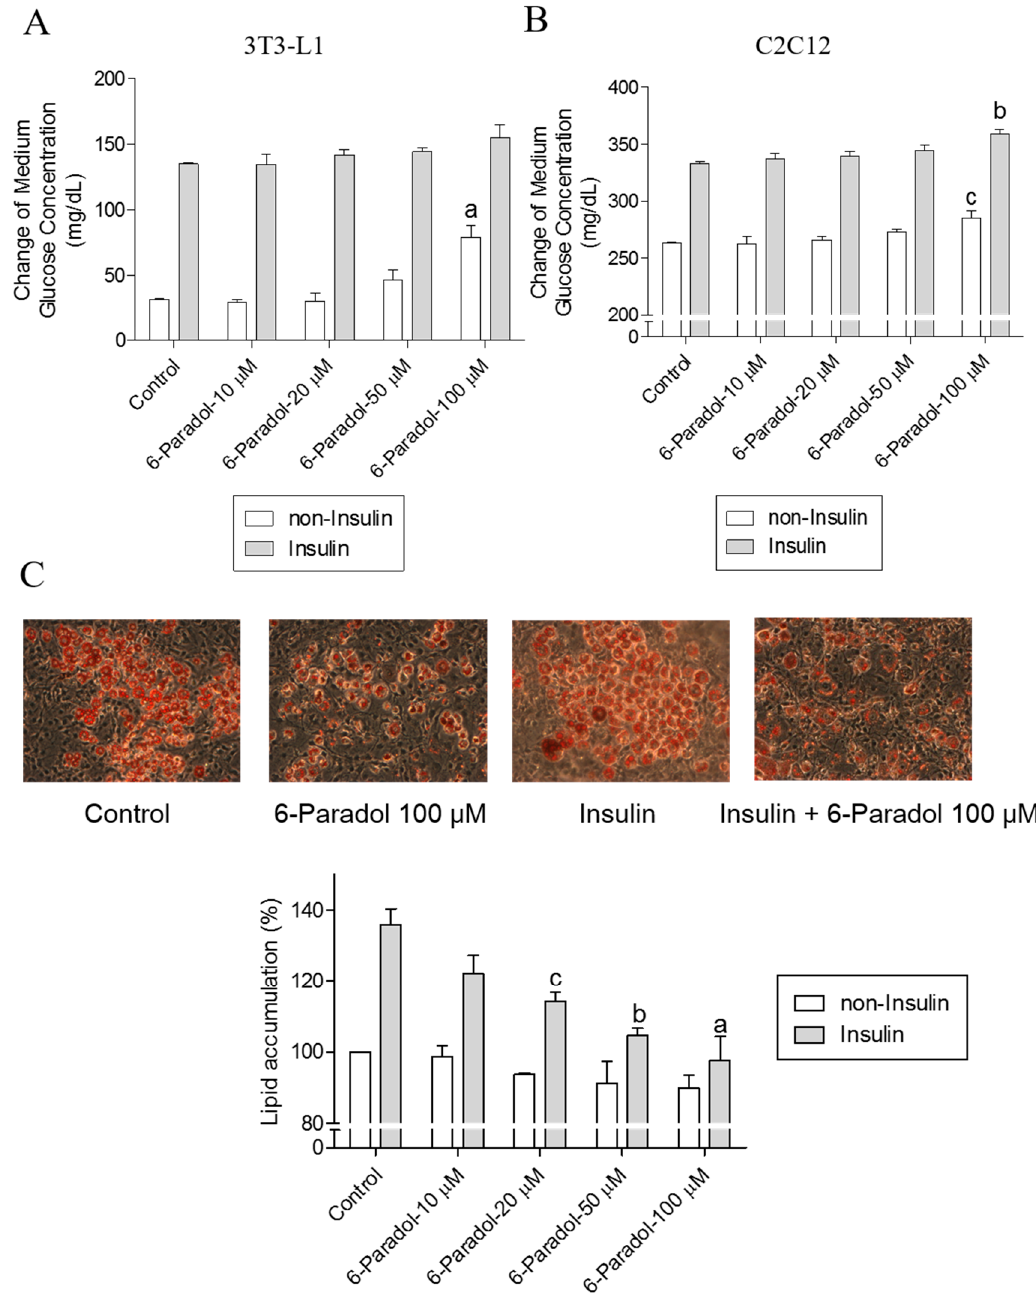
Figure 4. The effect of 6-paradol on glucose utilization and lipid synthesis. Medium glucose consumption in 3T3-L1 adipocytes ( A ) or C2C12 myotubes ( B ) in response to the treatment with 6-paradol. 3T3-L1 adipocytes or C2C12 myotubes were treated with the tested samples with or without insulin (0.32 µ M) in 450 mg/dL D -glucose DMEM. After 24 h, the remaining glucose concentration of the medium was measured using a chemistry analyzer. The data represent the amount of glucose in mg/dL consumed by the cells after 24 h of treatment. ( C ) Oil Red O staining and measurement of lipid content (magnification 200 × ). Results are the mean ± SEM of three independent experiments. a p < 0.001, b p < 0.01 and c p < 0.05 indicate a significant difference compared with the control group.